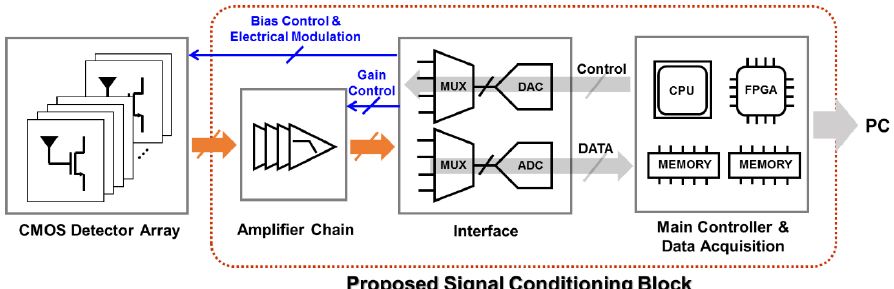
Figure 2. Block diagram of the overall system architecture of the proposed signal conditioning block.